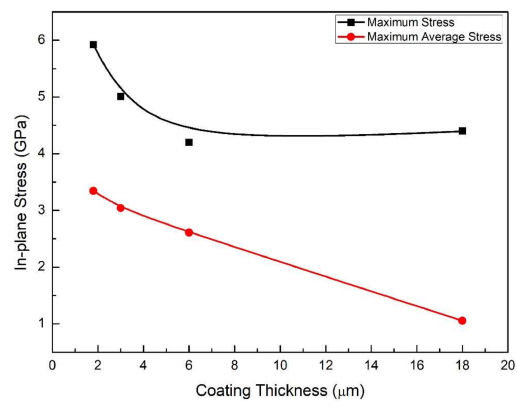
Figure 10. A comparison of the maximum TIS (red) and the maximum in-plane stress (black) found in the films of a series of